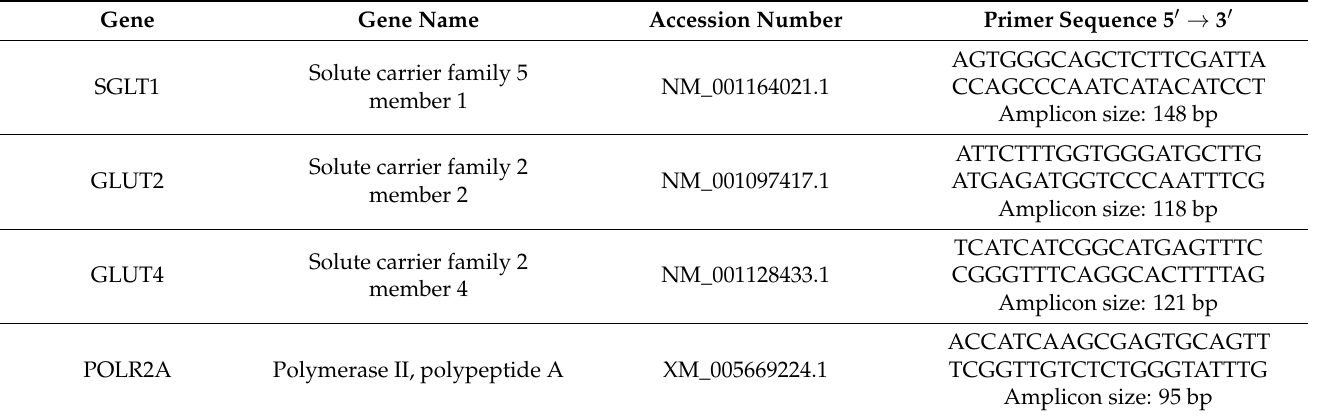
Table 2. Genes, primer sequences, and accession